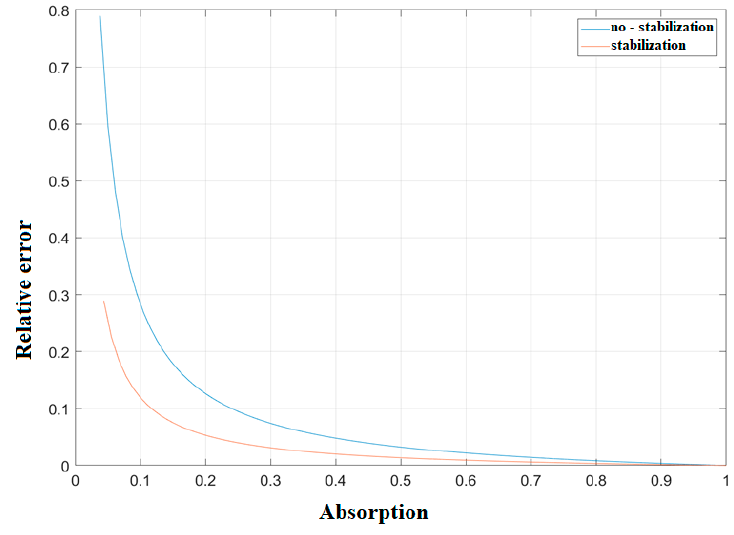
Figure 7. Simulated relative error vs the sound absorption value.